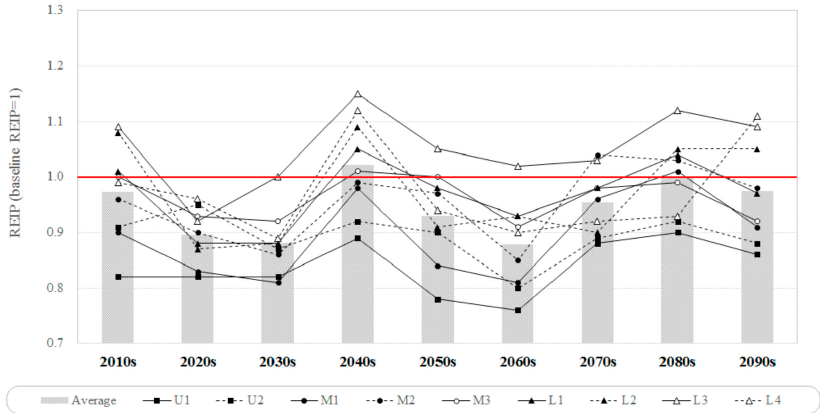
Figure 5. Temporal and regional changes in the REIP for climate change scenario RCP 8.5.